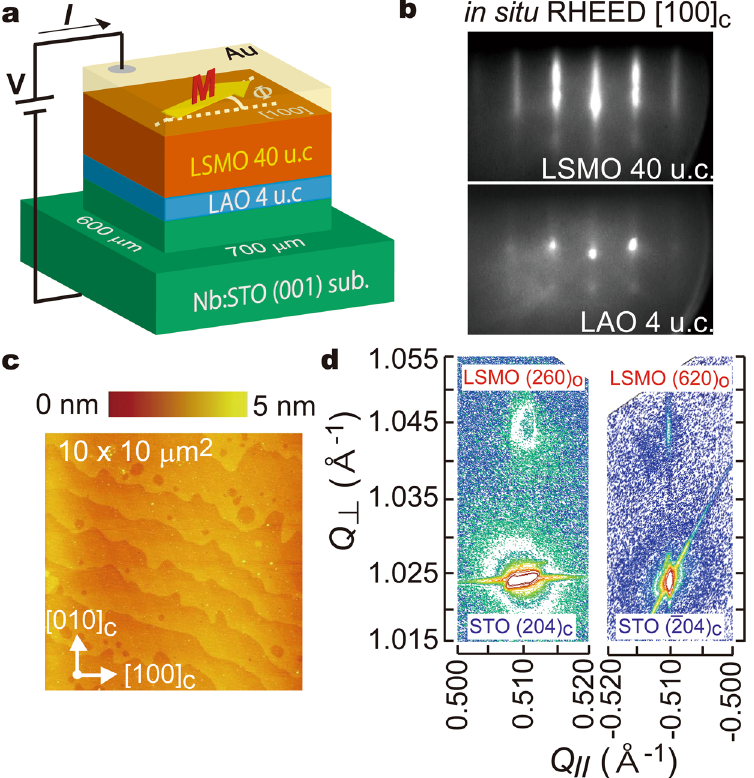
Figure 1. Sample preparation and characterization. ( a ) Device structure and tunneling transport measurement configuration of the LSMO/LAO/Nb:STO tunneling diode structure used in this study. ( b ) In-situ reflection high-energy electron-diffraction patterns in the [100] c direction of the LSMO and LAO layers. ( c ) Surface morphology of the LSMO/LAO/Nb:STO sample measured by atomic force microscopy. ( d ) Reciprocal lattice maps of the sample measured at room temperature. Here, Q // and Q ⊥ are the components of the reciprocal lattice vector in the in-plane [100] c and out-of-plane [001] c directions,